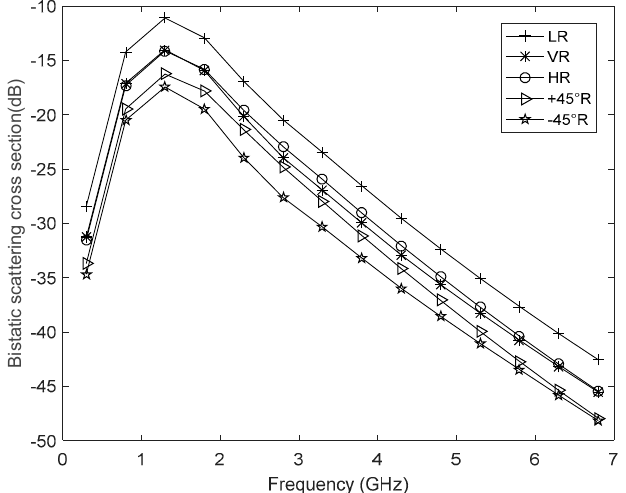
Figure 2. Variation of bistatic radar scattering cross section (BRCS) with frequency for five di ff erent polarizations.